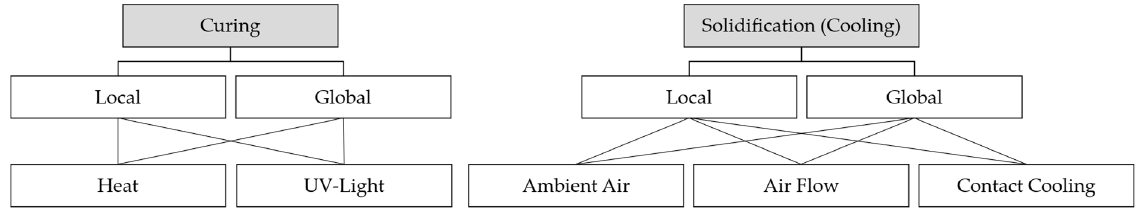
Figure 9. Possible process alternatives for curing and solidification.